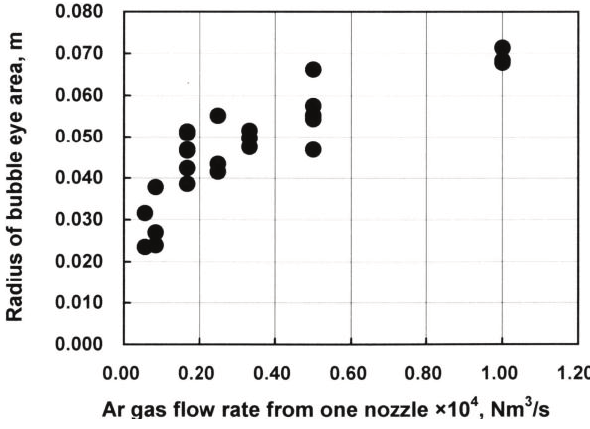
Figure 10. Relation between Ar gas flow rate and bubble eye